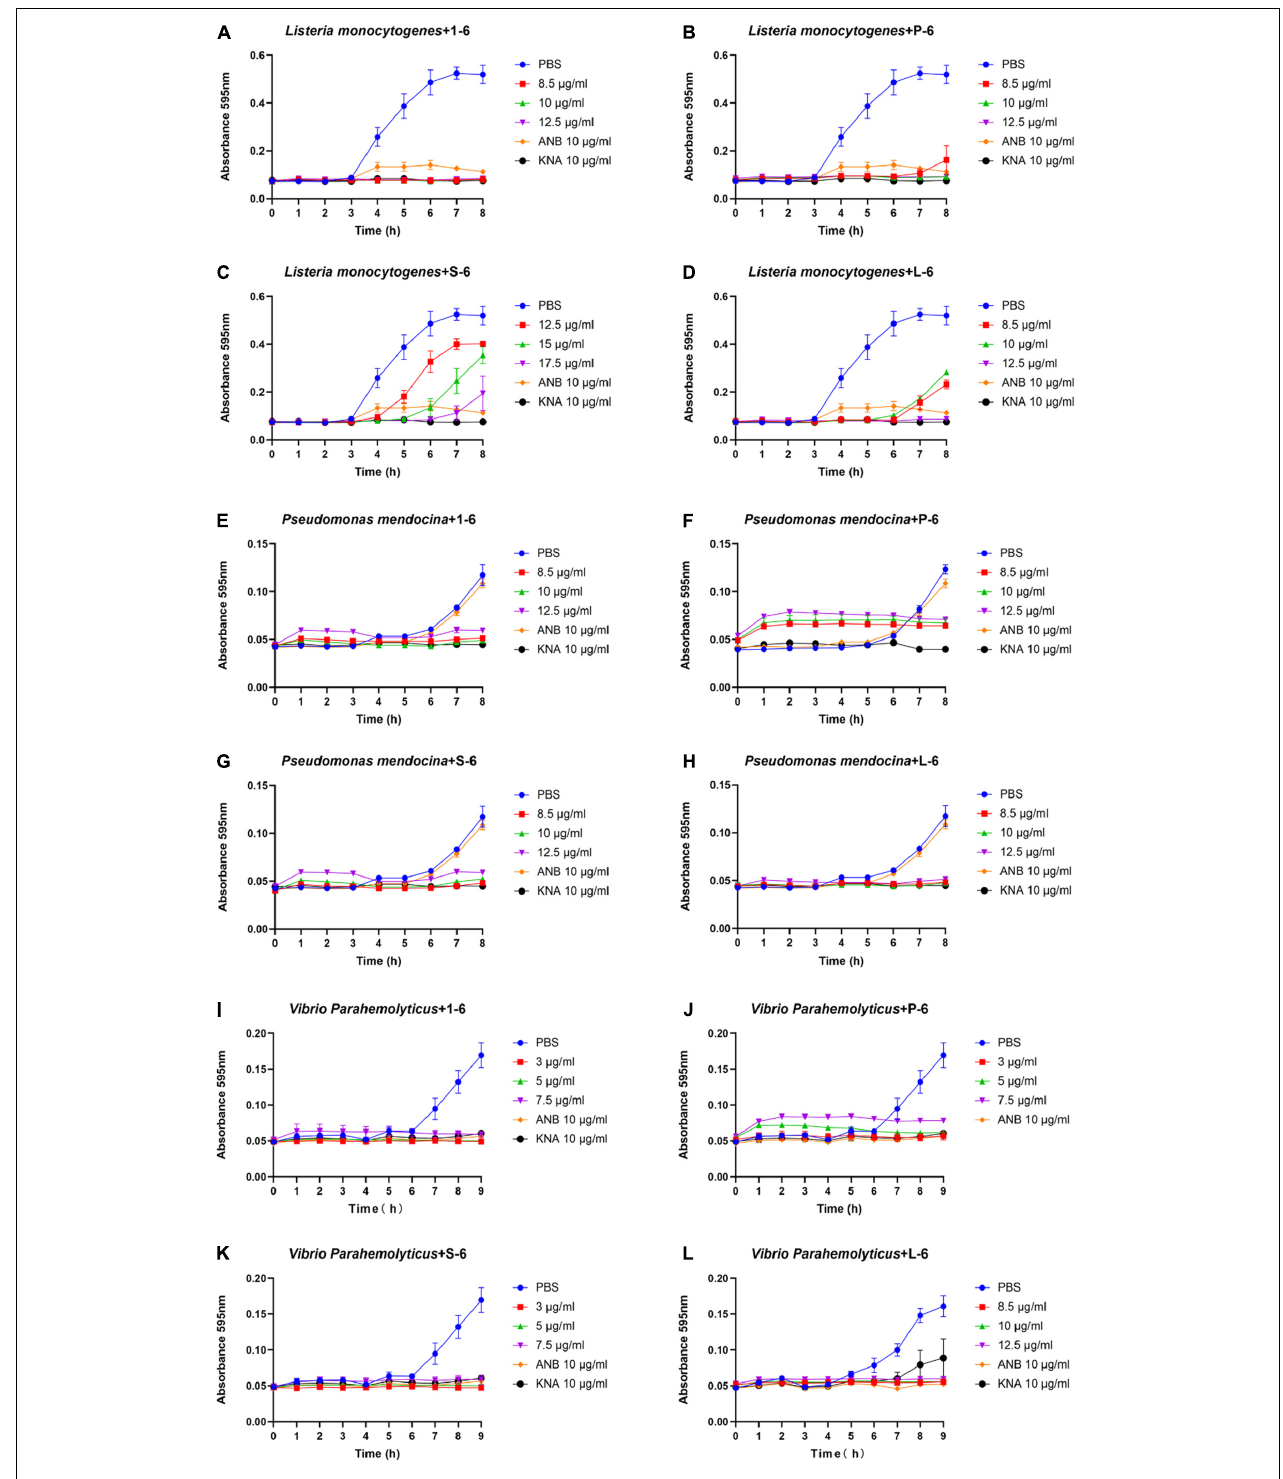
FIGURE 3 | Antibacterial activities of 1–6, P-6, S-6, and L-6 against three bacteria. (A) L. monocytogenes treated with 1–6. (B) L. monocytogenes treated with P-6. (C) L. monocytogenes treated with S-6. (D) L. monocytogenes treated with L-6. (E) P. mendocina treated with 1–6. (F) P. mendocina treated with P-6. (G) P. mendocina treated with S-6. (H) P. mendocina treated with L-6. (I) V. parahaemolyticus treated with 1–6. (J) V. parahaemolyticus treated with P-6. (K) V. parahaemolyticus treated with S-6. (L ) V. parahaemolyticus treated with L-6.